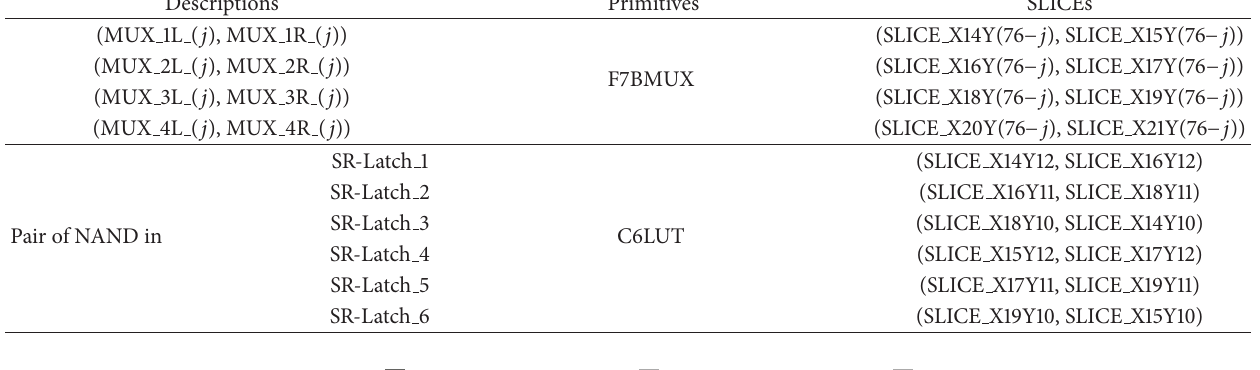
Table 1: Placement of primitives on SLICEs for 3-1 Double Arbiter PUF. The value for the variable 𝑗 can range from 0 to 63. Descriptions